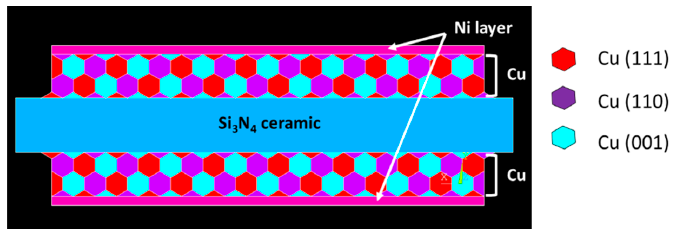
Figure 2. FEM model for thermal stress distribution simulation of an AMB substrate with Si 3 N 4 .